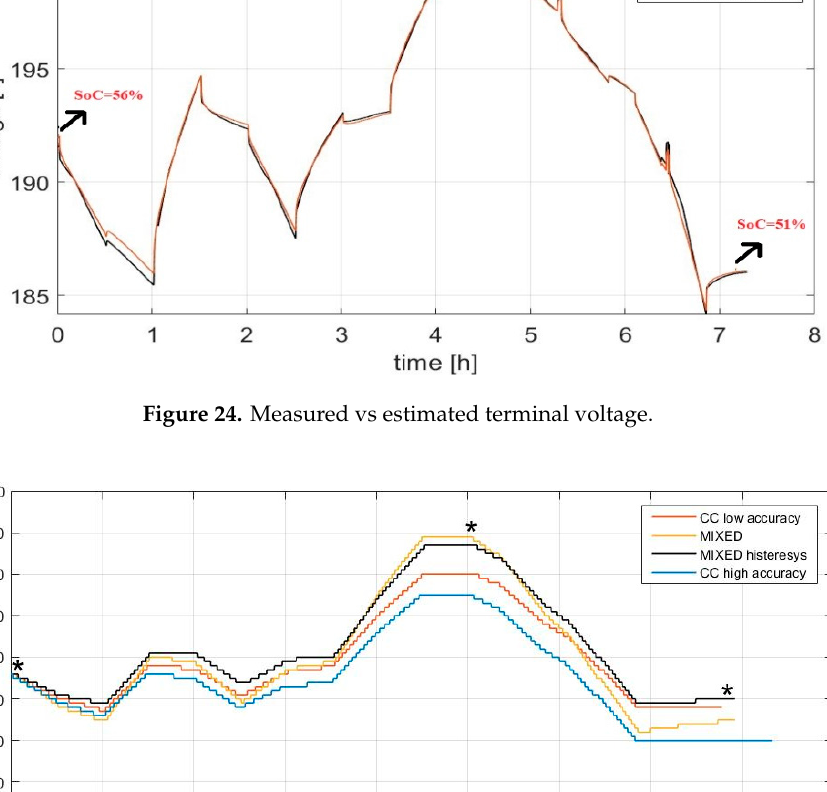
Figure 23. Test for algorithm evaluation.